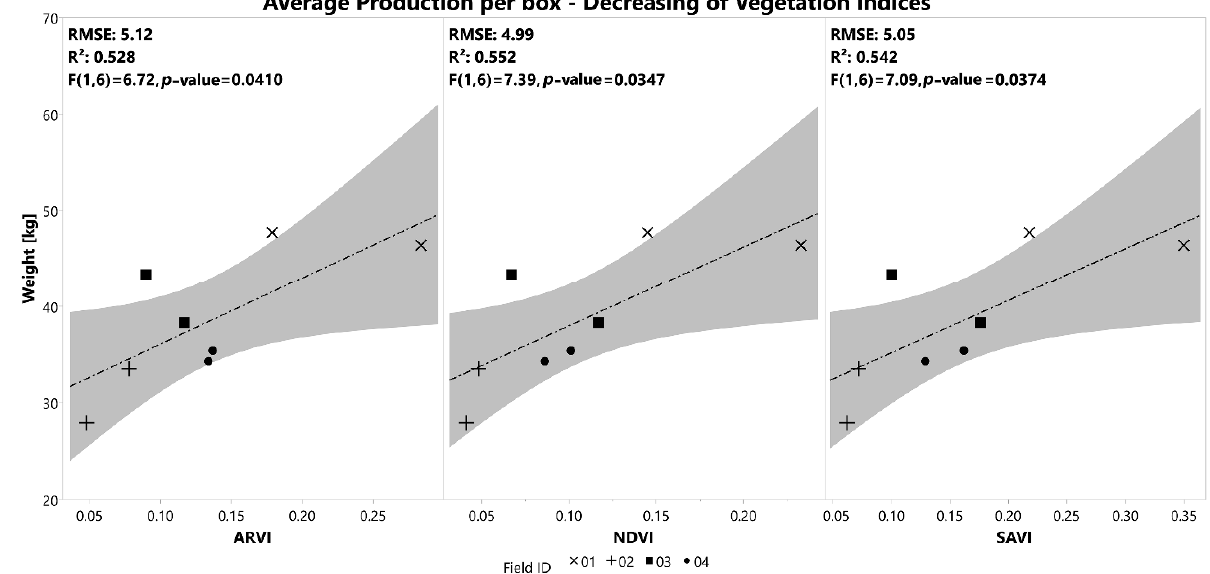
Figure 5. Average production per box [kg] in relation to decreasing vegetation indices during the fifth instar of B. mori . Gray shaded areas represent the confidence interval of regression at 95%.